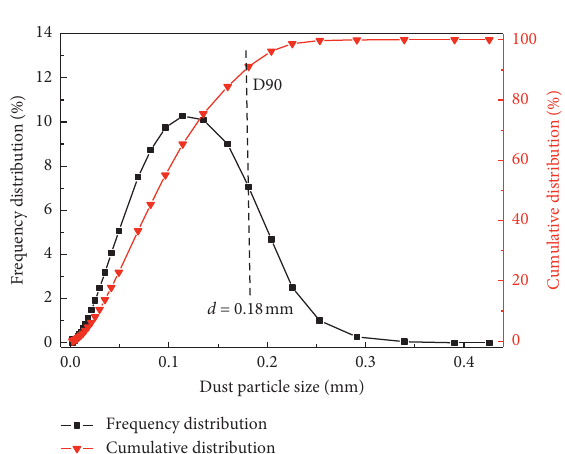
Figure 7: Dust particle size frequency and cumulative